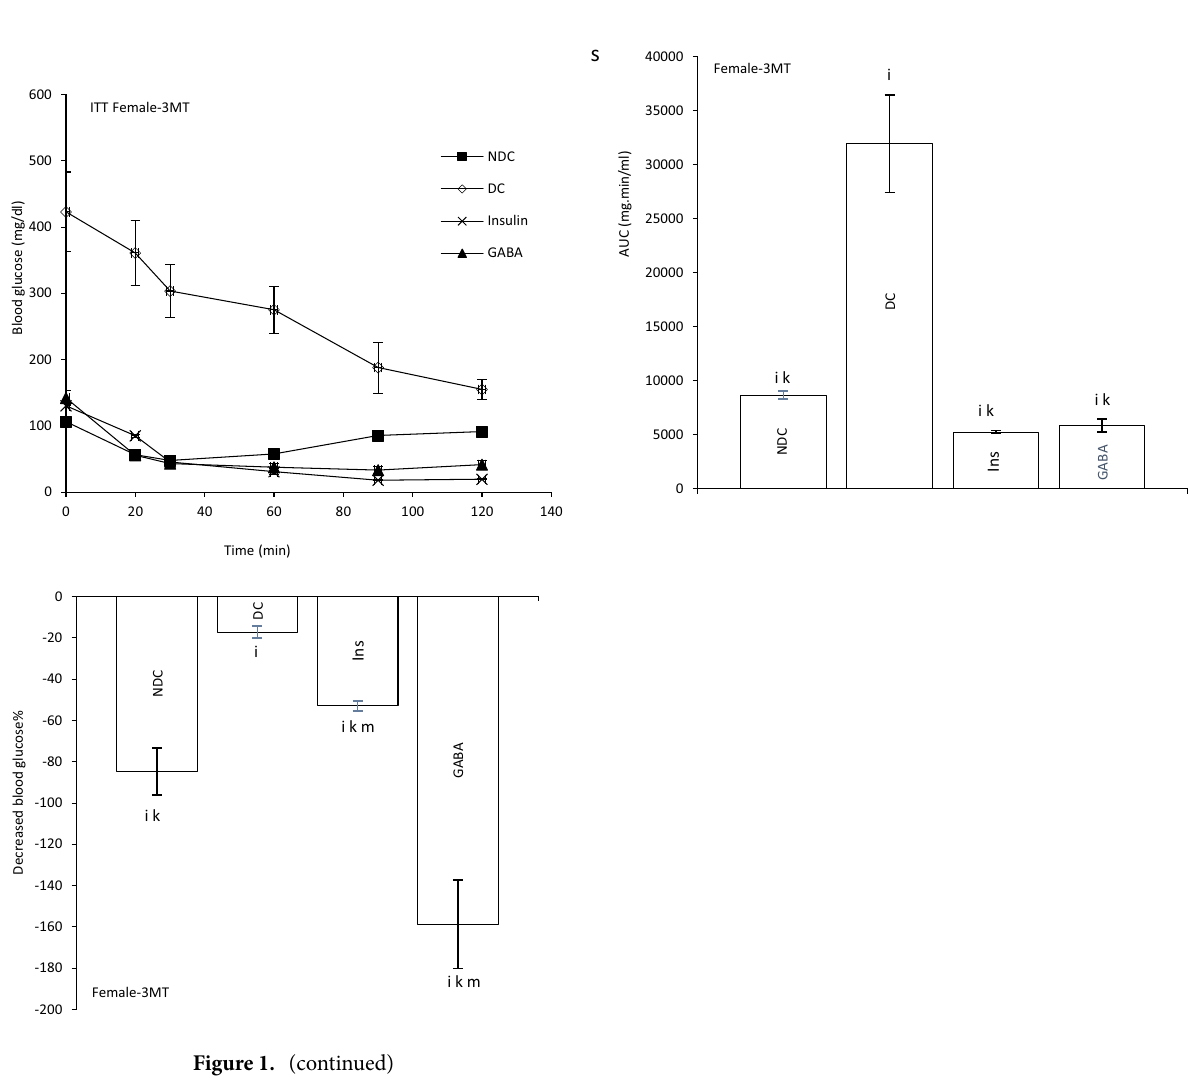
in compared to offspring of DC groups. On the other hand, serum LDL levels in the female Ins group ( P < 0.01) and male GABA group ( P < 0.05) were significantly reduced in compared to the DC group. Details of offspring serum TG, cholesterol, LDL and VLDL changes in different groups are given in Fig.